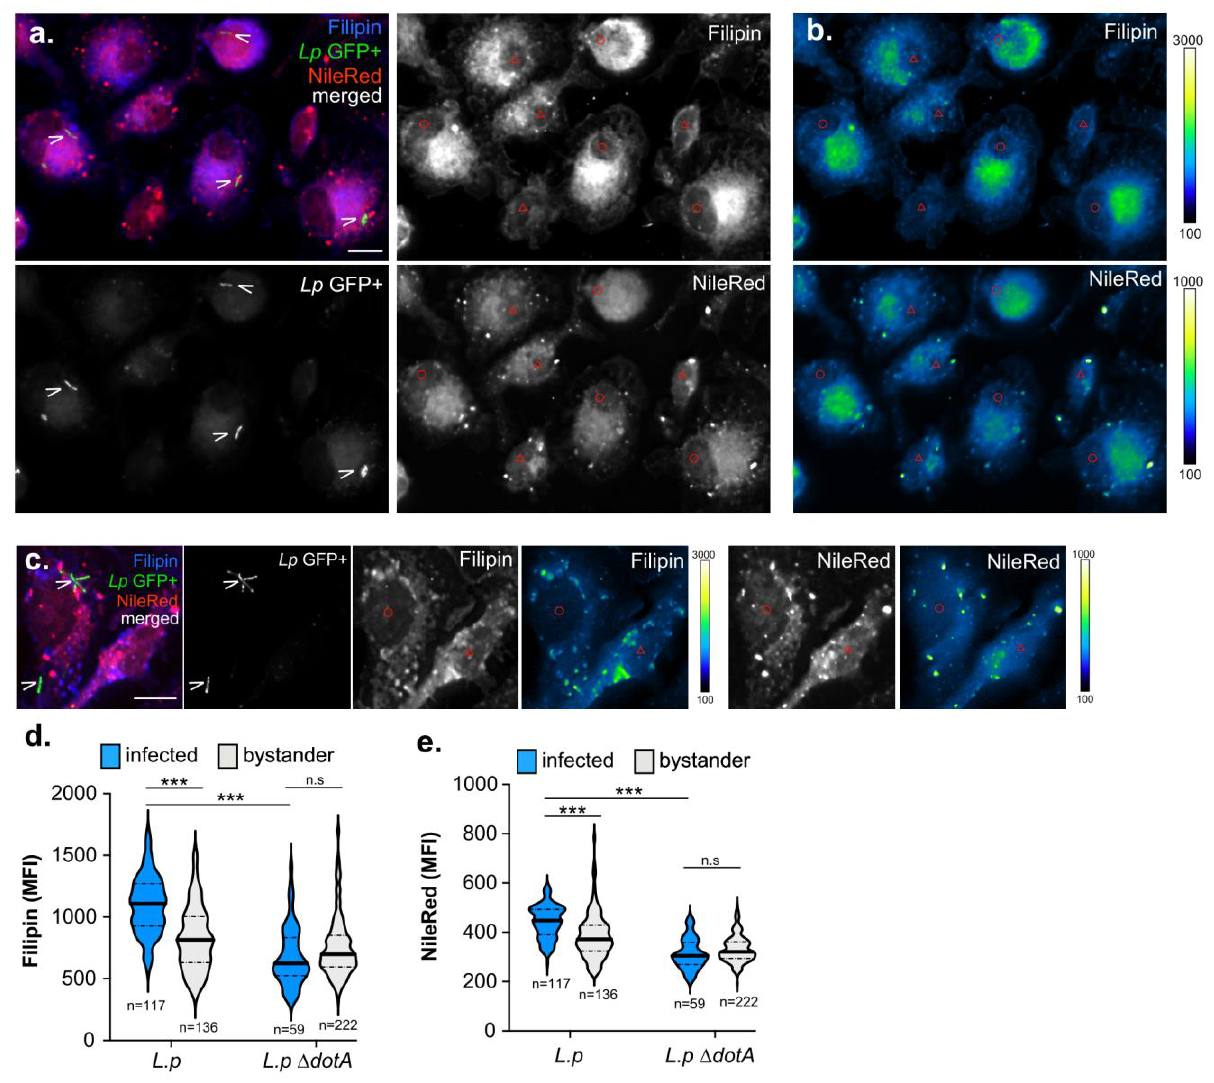
FIGURE 6: Microscopy analysis of cholesterol and neutral lipids content of BMDMs infected with L. pneumophila . (a-c) Representative micrographs of 3D projections from infected (O) and bystander (∆) BMDMs at six hpi with GFP-expressing Lp01 ∆ flaA (a-b) or Lp01 ∆ f laA∆dotA . Cells were stained with Filipin and NileRed for visualization of the cellular pools of cholesterol and neural lipids, respectively. LCVs are indicated with arrow heads (>) (b-c) Show individual channels pseudo-colored with the Kindlmann color map. ( d-e) Violin Plots of Filipin (d) and NileRed (e) mean fluorescent intensity (MFI) in infected and bystander macrophages at six hpi. n - the number of cells included in each condition. n.s – not significant, *** p<0.0001 (two-tailed unpaired T-test) (a-e) Representative data from one of three biological replicates are